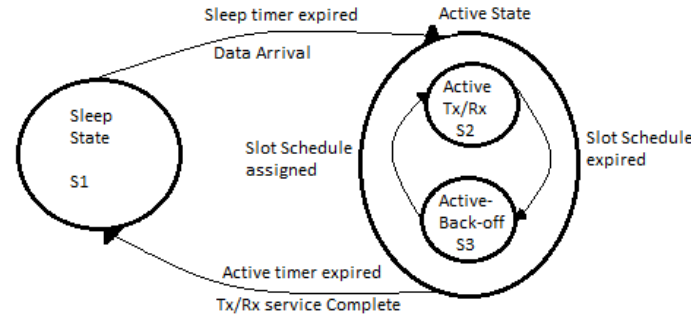
Figure 8. Node’s State transition